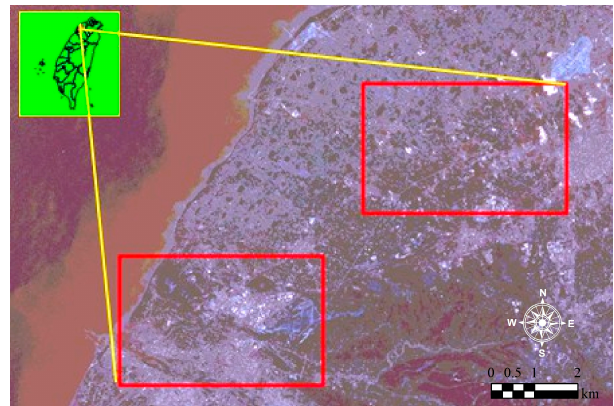
Figure 2. Picture of Hsinchu and Taoyuan study areas.